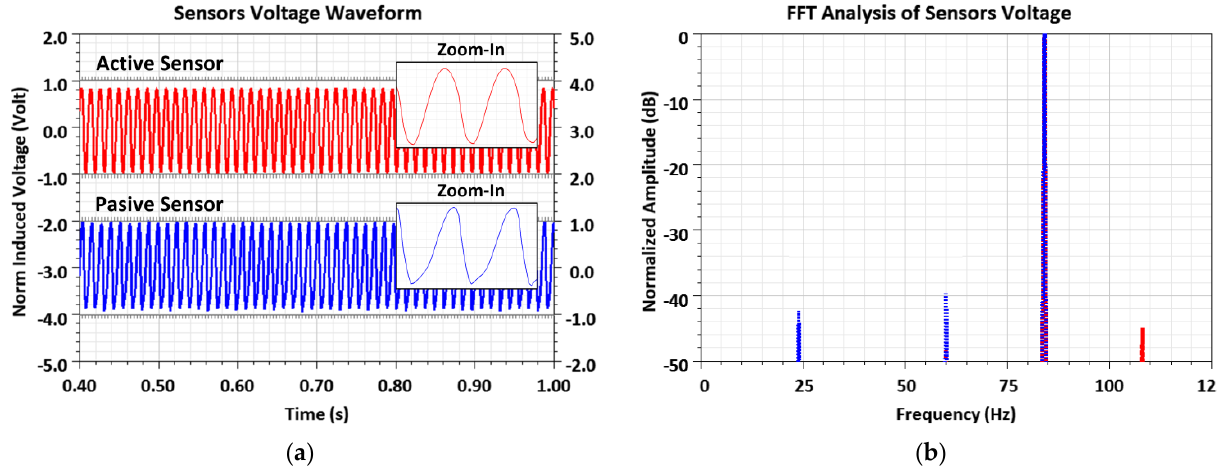
Figure 7. FEM model of a healthy rotor without any defects: ( a ) normalized waveforms of the induced voltages in the sensors; ( b ) FFT analysis of induced voltage waveforms.